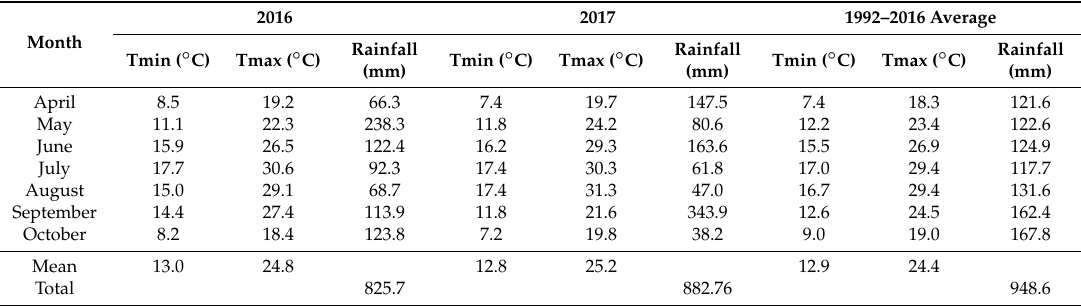
Table 2. Monthly mean maximum temperature (Tmax), minimum temperature (Tmin), and total rainfall during the growing seasons at Udine (Italy) in 2016 and 2017, as well as the 25-year mean (1992–2016) at